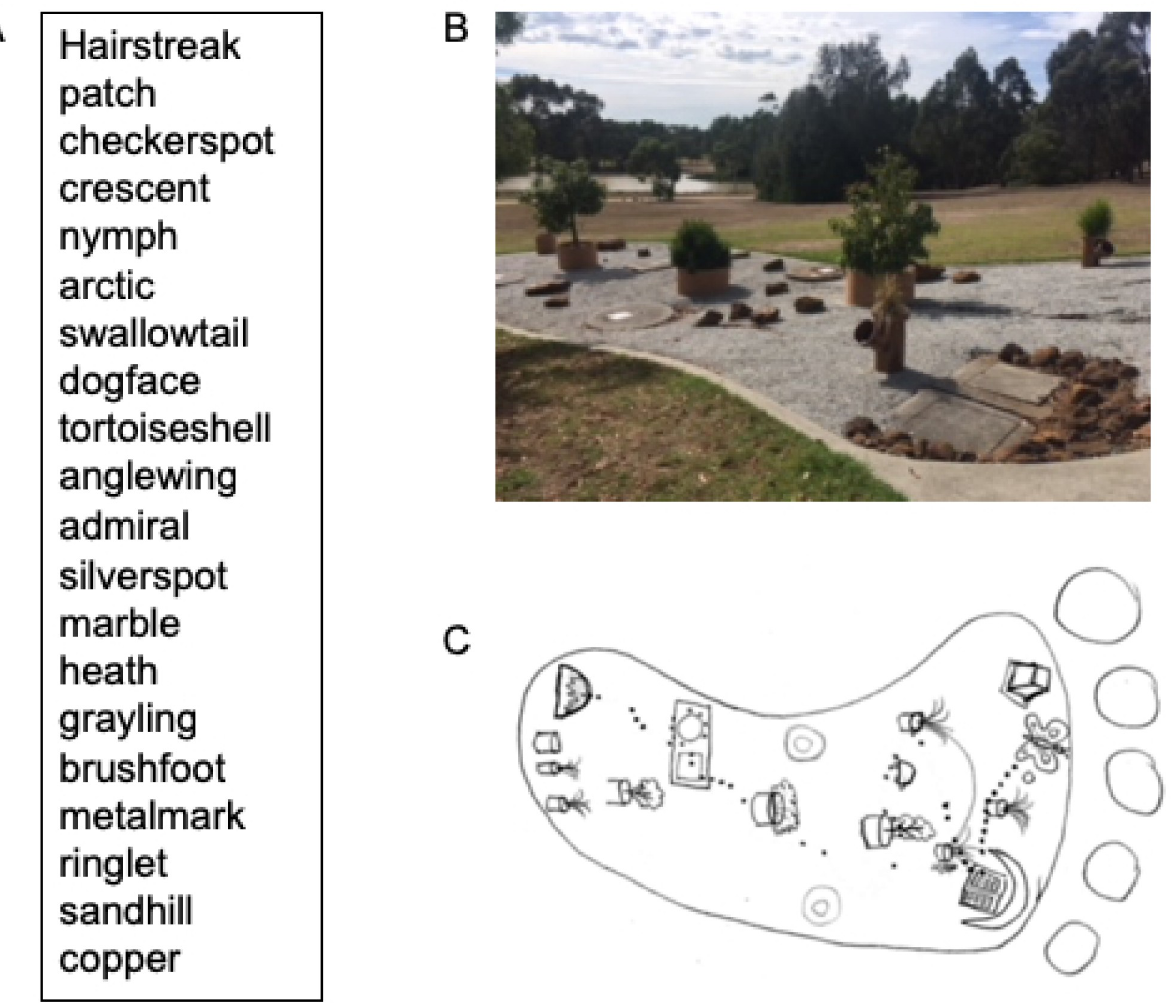
Fig 1. Item list for recall testing and physical layout of the area used for construction of the narrative in the Australian Aboriginal memorization technique. A) List of common names of butterfly species extracted from: https://www.jeffpippen.com/butterflies.htm. B) photo (by author) of the rock garden at Churchill, Victoria used for teaching and building the narrative structure for the Australian Aboriginal memory-trained group. C) Schematic hand-drawn map indicating the position and order of items in the rock garden in (B) used in the narrative.